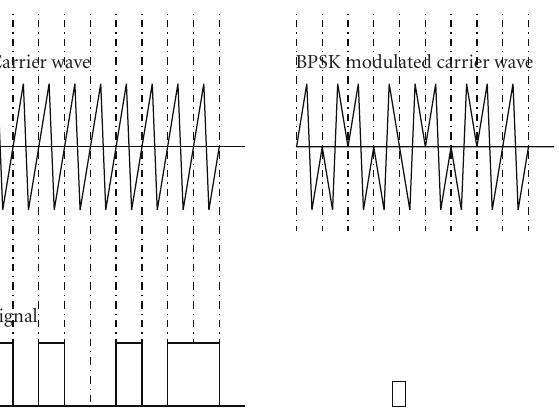
Figure 1: Binary phase-shift keying (BPSK modulation technique).